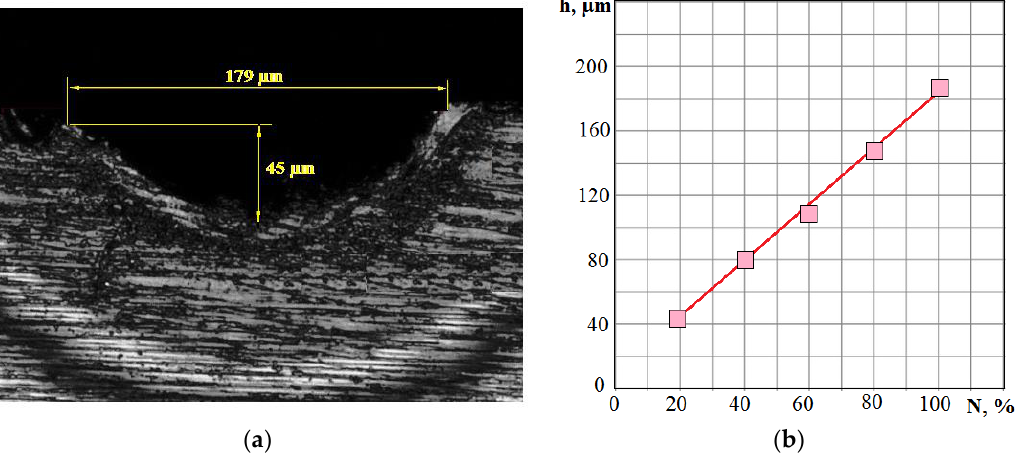
Figure 3. A photograph of the cross-section of the trace on the aluminum alloy surface after the laser beam discharge with 20% of the maximum power ( a ); the trace depth dependence on the laser power ( b ).